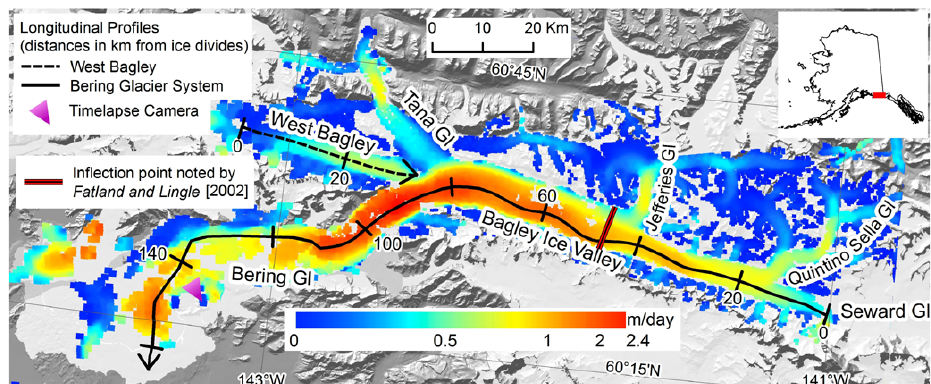
Fig. 1. Composite velocity map of the BGS and Tana Glacier in Winter 2010. The BGS and WB longitudinal profiles apply to Figs. 2 and 4, respectively. Profiles begin at ice divides and distances increase in the direction of flow. White glacier outline provided by Armstrong et al.